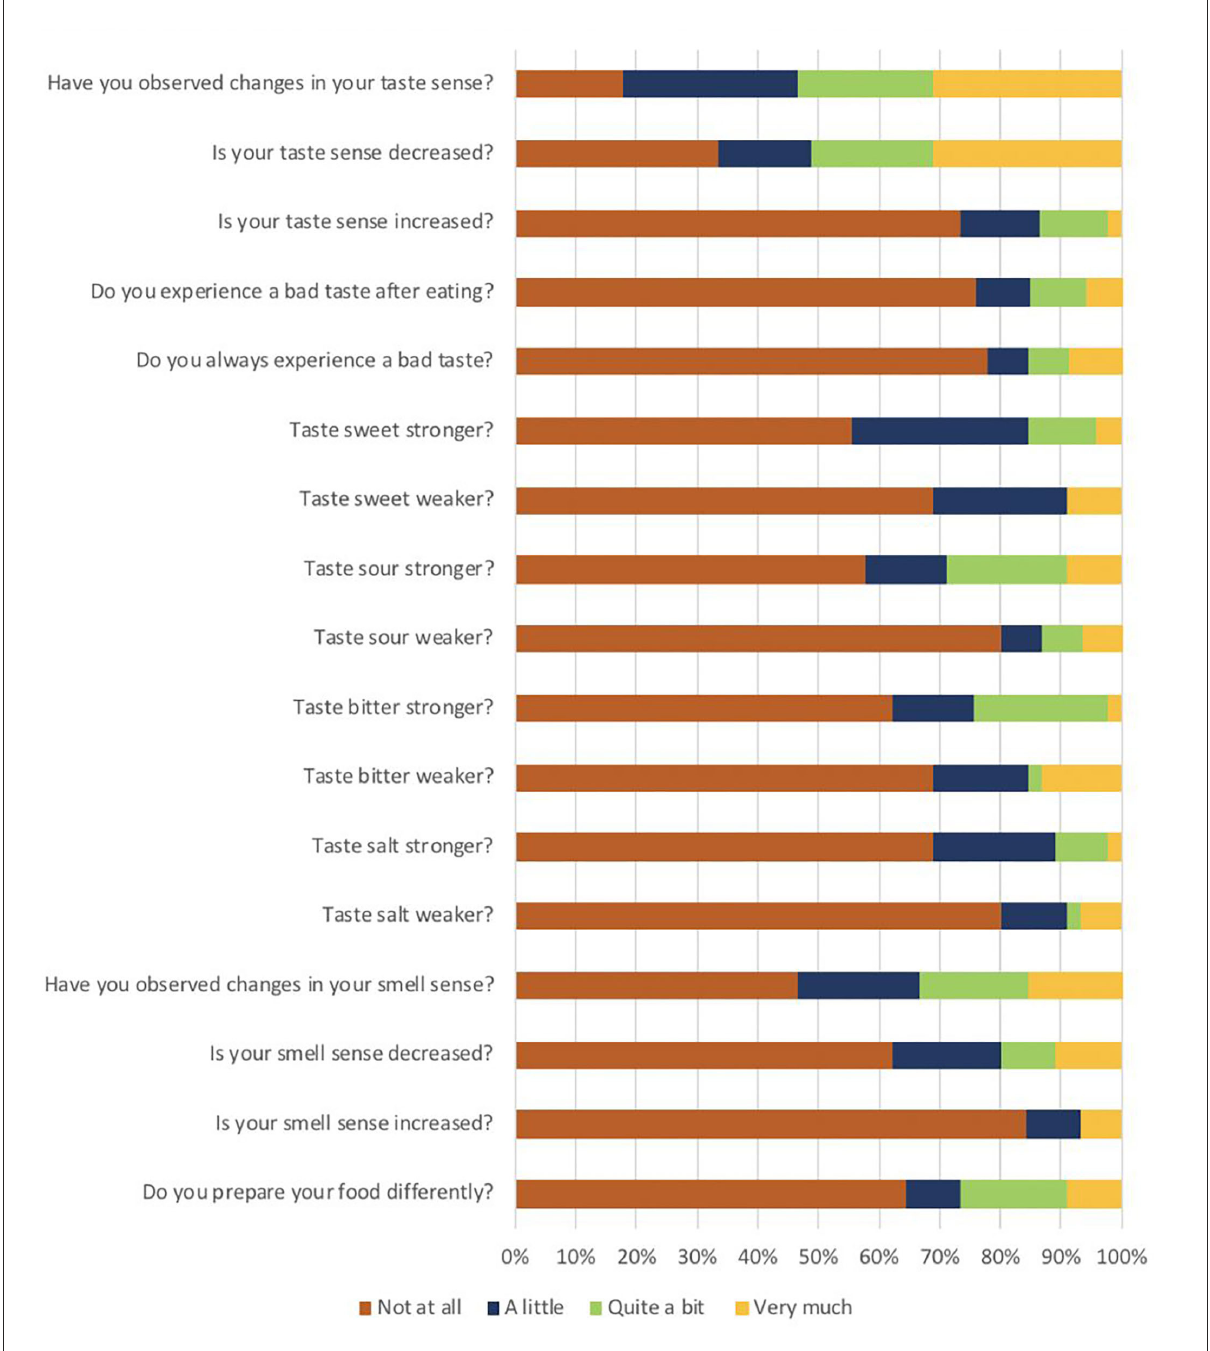
FIGURE2 Distribution of the responses to the taste and smell addendum of the EORTC QLQ–C30 ( N =